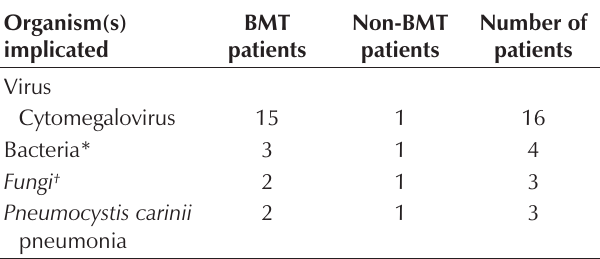
Organisms implicated in antimicrobial therapy changes postbronchoscopy and bronchoalveolar